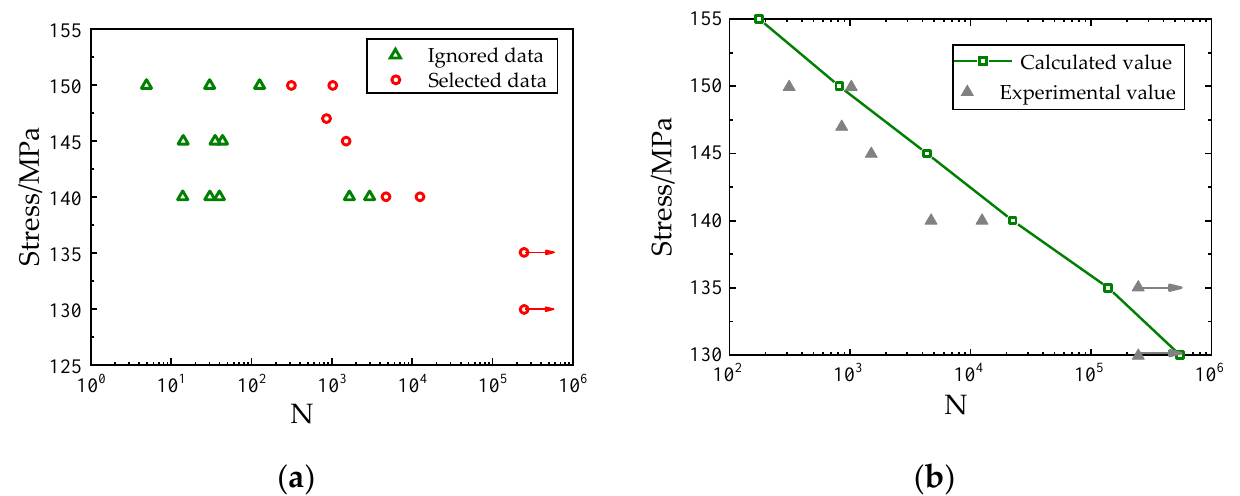
Figure 6. Comparison between the calculated results of fatigue life based on the submodel and the experimental results.